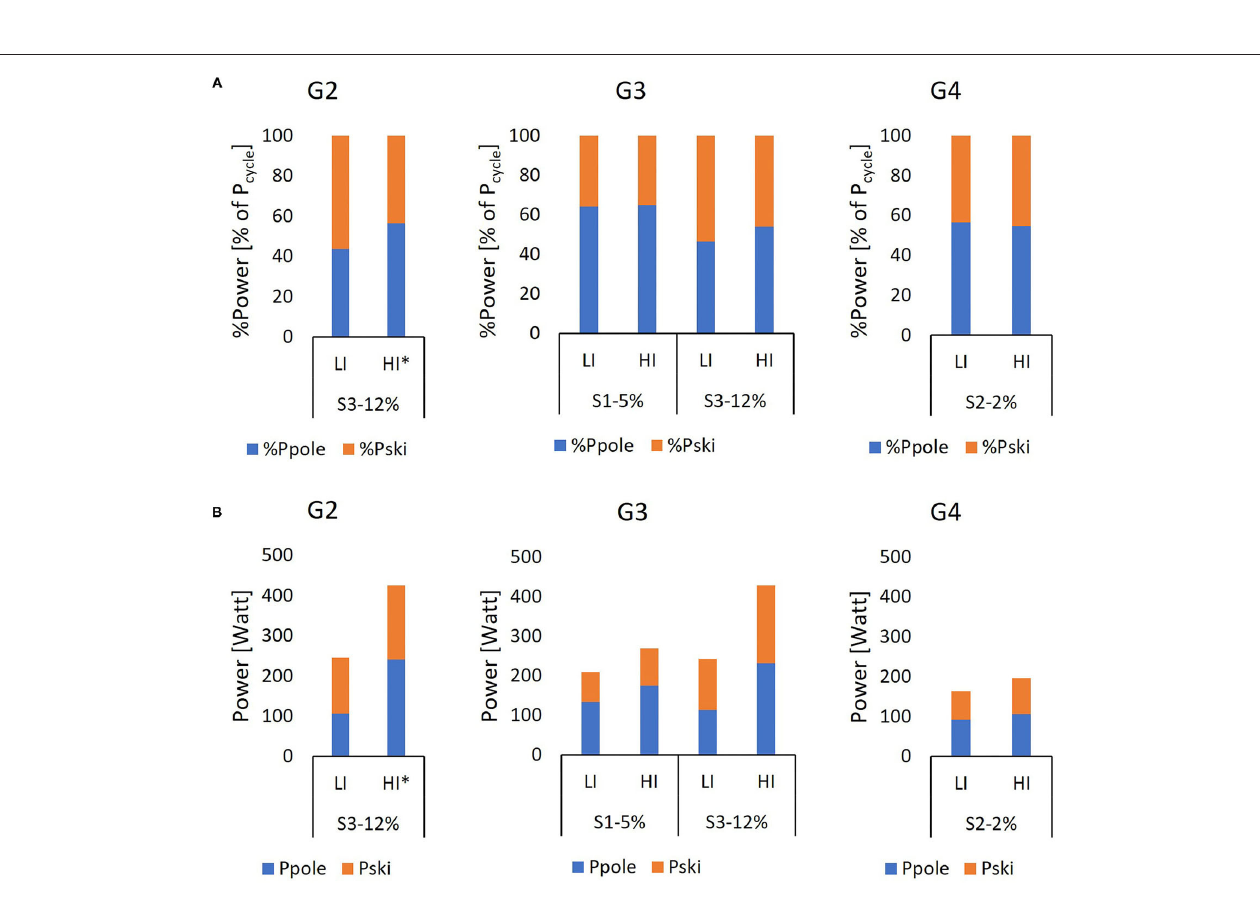
FIGURE 5 | Mean values for (A) relative and (B) absolute pole power (%P pole , P pole ) and ski power (%P ski , P ski ) during the LI and HI sessions for all sub-techniques and segments (i.e., S1–S3) for all skiers ( n = 8) with power data. During the HI session, G2 was used only by five skiers, one of whom was missing power data, hence the small